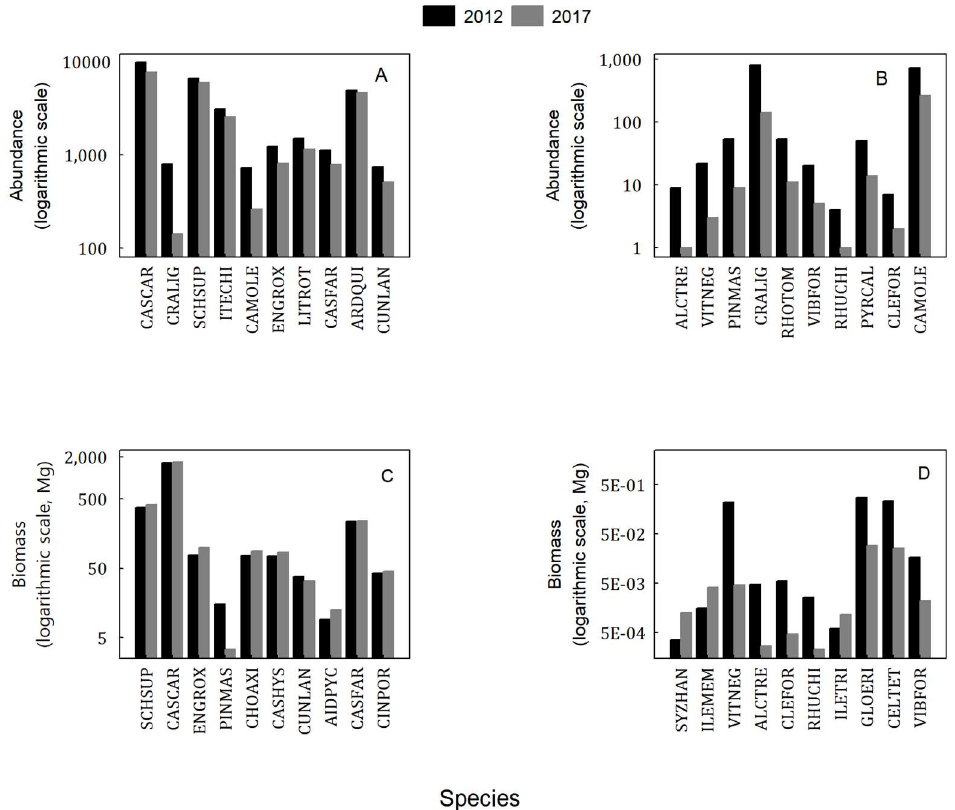
Figure 3. Changes in abundance ( A and B ) and biomass ( C and D ; logarithmic scale) of ten dominant species during forest succession. Species code: AIDPYC, Aidia pycnantha (Drake) Tirveng.; ALCTRE, Alchornea trewioides (Benth.) Müll. Arg.; ARDQUI, Ardisia quinquegona Blume; CAMOLE, Camellia oleifera Abel; CASCAR, Castanopsis carlesii (Hemsl.) Hayata; CASFAR, Castanopsis fargesii Franch.; CASHYS, Castanopsis hystrix Hook. f. and Thomson ex A. DC.; CELTET, Celtis tetrandra Roxb.; CHOAXI, Choerospondias axillaris (Roxb.) B.L. Burtt and A.W. Hill; CINPOR, Cinnamomum porrectum (Roxb.) Kosterm.; CLEFOR, Clerodendrum fortunatum L.; CRALIG, Cratoxylum cochinchinense (Lour.) Blume; CUNLAN, Cunninghamia lanceolata (Lamb.) Hook.; ENGROX, Engelhardtia roxburghiana Lindl.; GLOERI, Glochidion eriocarpum Champ. ex Benth.; ILEMEM, Ilex memecylifolia Champ. ex Benth.; ILETRI, Ilex triflora Blume; ITECHI, Itea chinensis Hook. and Arn.; LITROT, Litsea rotundifolia Hemsl.; PINMAS, Pinus massoniana Lamb.; PYRCAL, Pyrus calleryana Decne.; RHOTOM, Rhodomyrtus tomentosa (Aiton) Hassk.; RHUCHI, Rhus chinensis Mill.; SCHSUP, Schima superba Gardner and Champ.; SYZHAN, Syzygium hancei Merr. and L.M. Perry; VIBFOR, Viburnum fordiae Hance; VITNEG, Vitex negundo L.